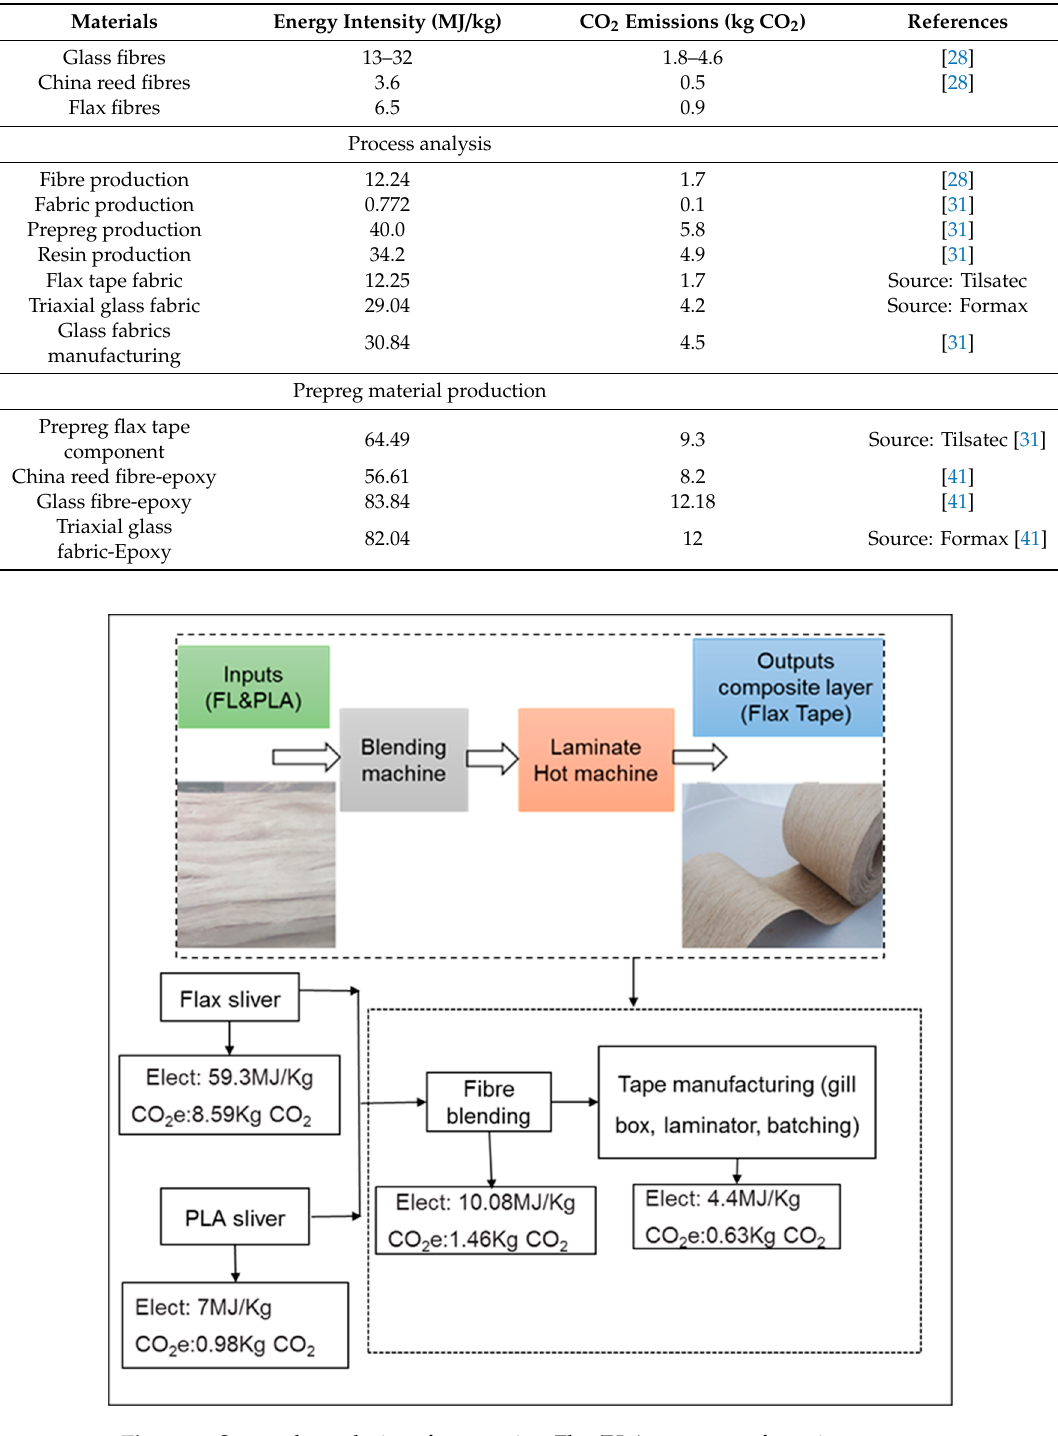
/ PLA tape manufacturing